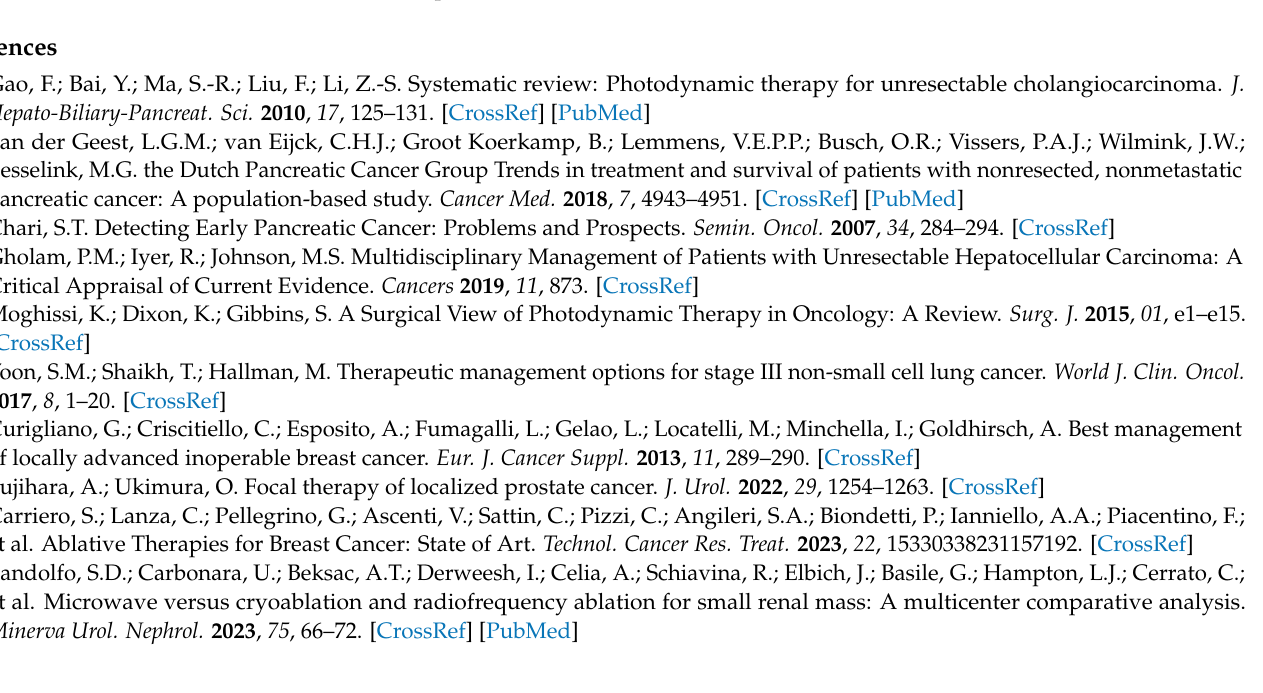
Table S1: Basic Media, Table S2: MC38 Media, Table S3: B16.F10 Media, Table S4: T Cell